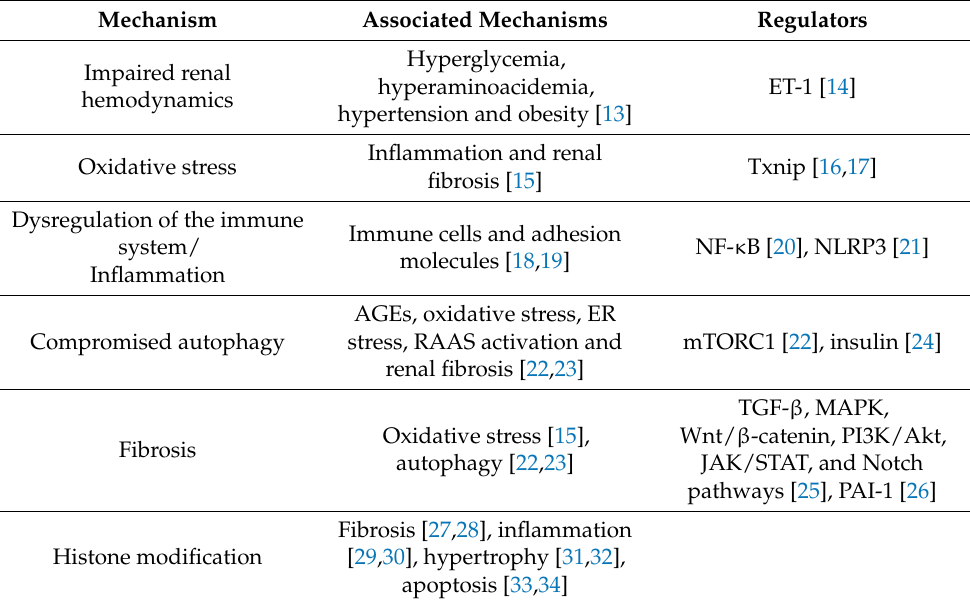
Table 2. Principal mechanisms implicated in the pathogenesis of diabetic kidney